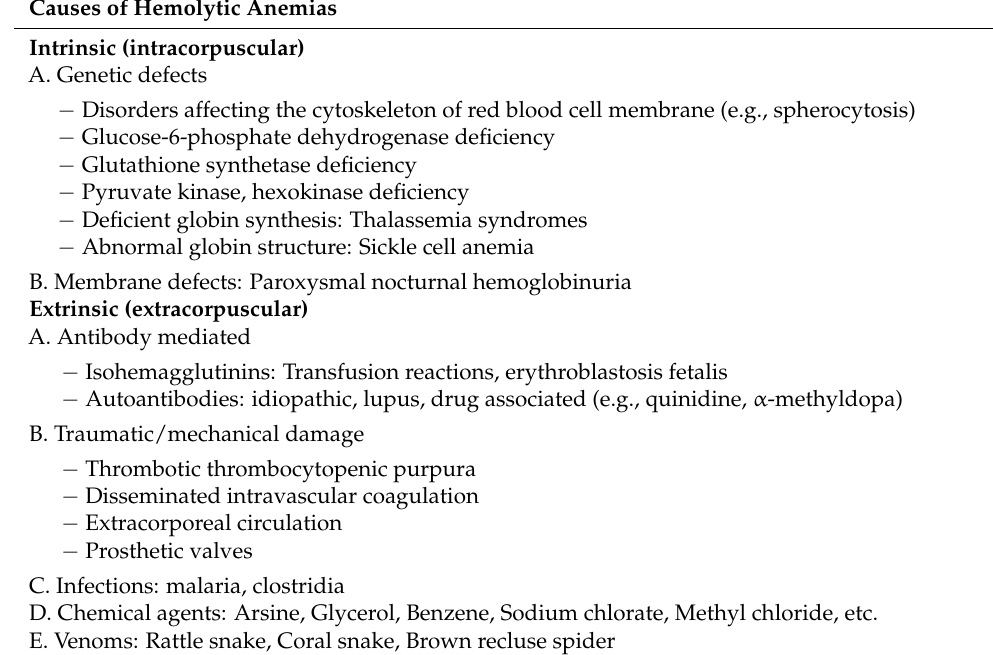
Table 1. Partial list of different insults/mechanisms that lead to hemolysis. Causes of Hemolytic